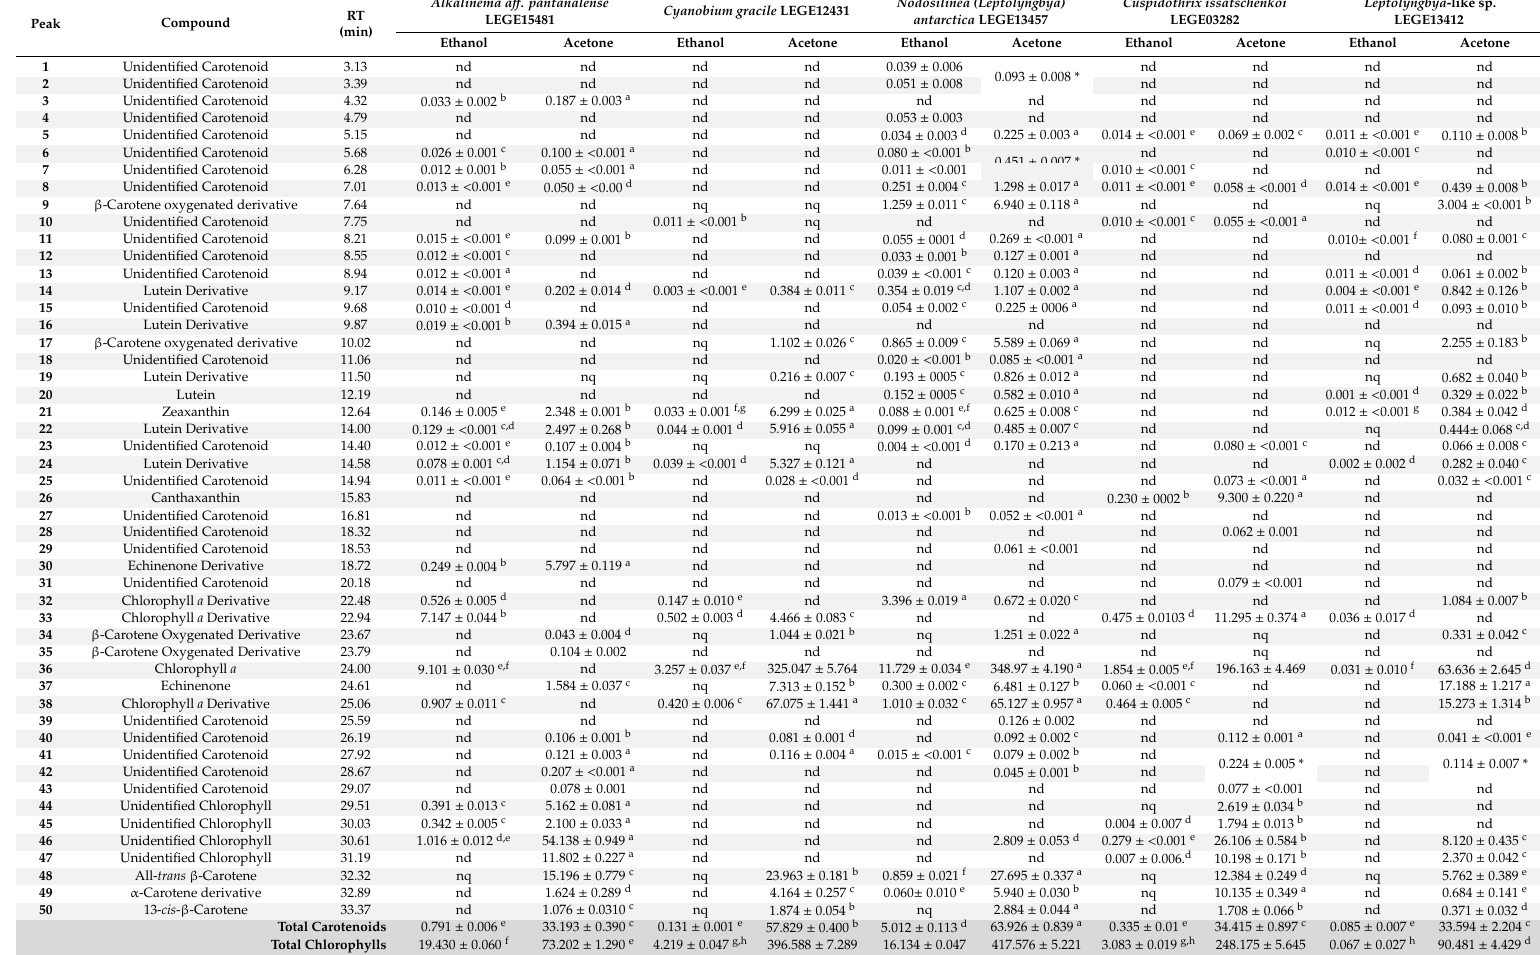
Table 3. Carotenoid and chlorophyll contents ( µ g / mg of dry extract) in ethanol 70% v / v and acetone extracts of cyanobacteria, determined by HPLC-PDA 1,2 .